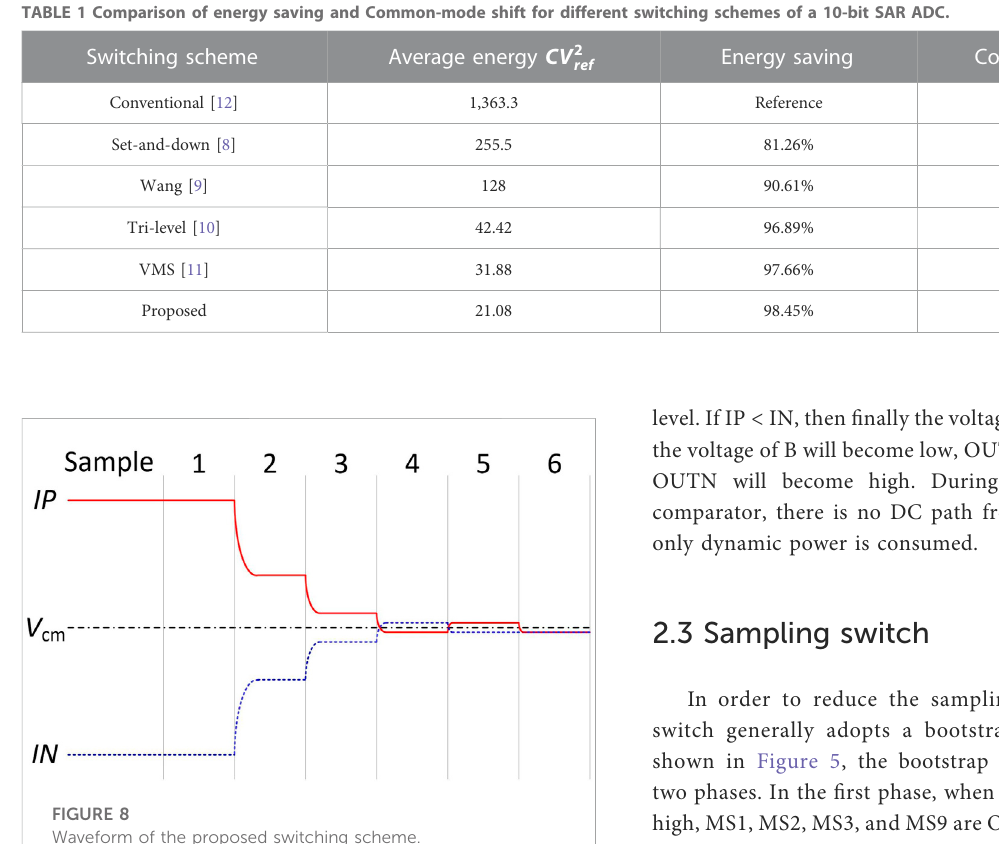
FIGURE 8 Waveform of the proposed switching